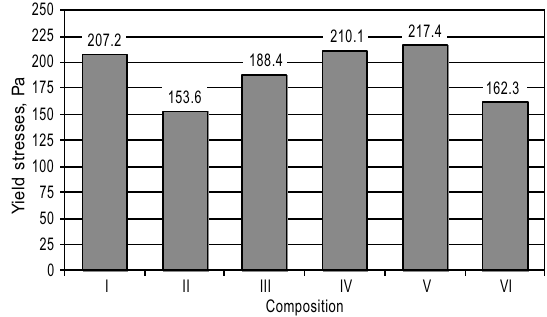
Fig. 3. Dependence of the yield stresses of cement pastes on different modifiers